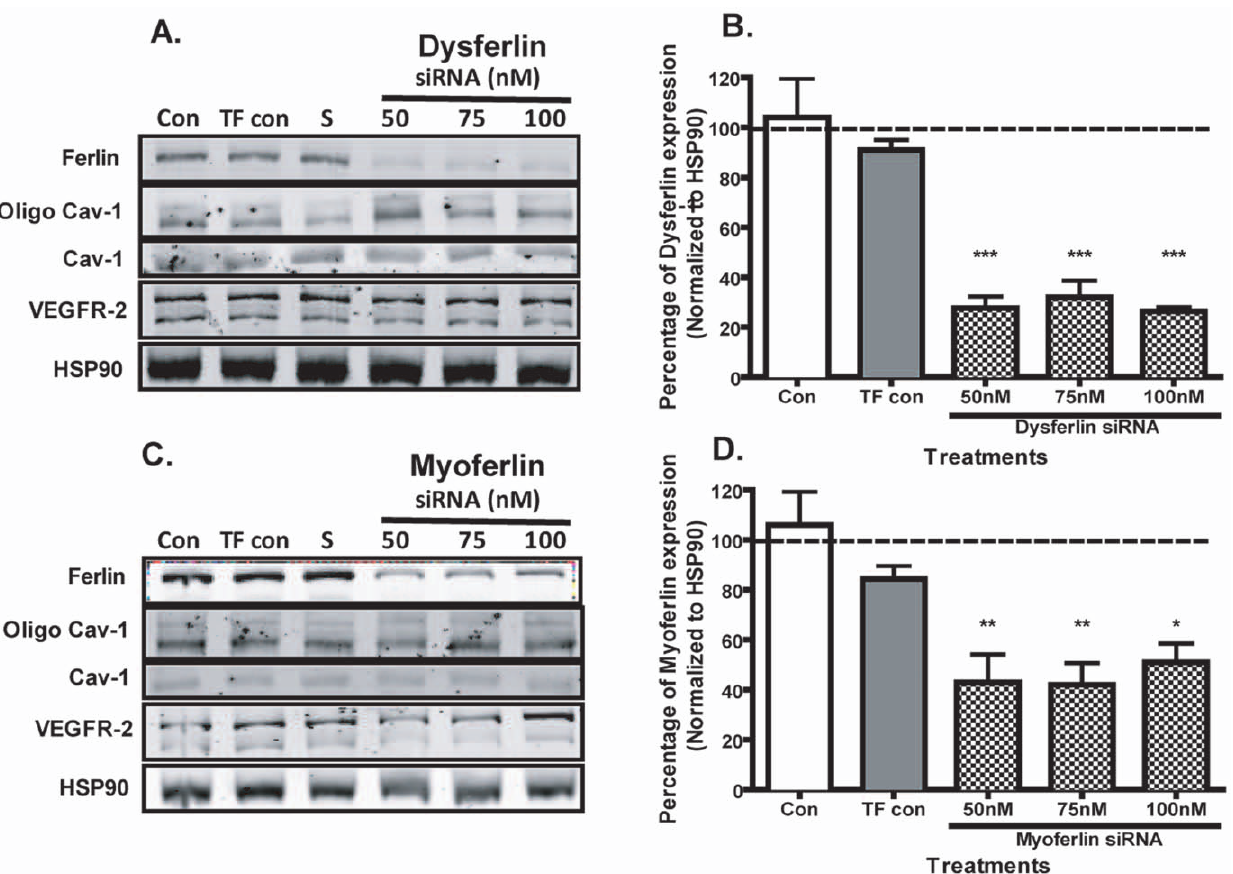
Figure 4. No effect of dysferlin or myoferlin knockdown on VEGFR-2 and caveolin-1 expression. 16HBE cells were transfected with oligofectamine transfection reagent (TF con), scrambled siRNA (S), dysferlin or myoferlin siRNA at 50 nM, 75 nM and 100 nM for 72 h. The representative immunoblot of three independent experiments demonstrates that siRNA specific for (A) dysferlin and (C) myoferlin had no effect on caveolin-1 or vascular endothelial growth receptor 2 (VEGFR-2) protein expression. Densitometry analysis of band intensities for (B) dysferlin and (D) myoferlin normalized to HSP90 compared to the scrambled siRNA control (dotted line), indicate knock down of 50% or more for each ferlin protein. Values are represented as mean ( 6 SEM) of three independent experiments. A significant difference between the treatment groups with scrambled siRNA is indicated by asterisk (* p , 0.05; ** p , 0.01, *** p , 0.005).